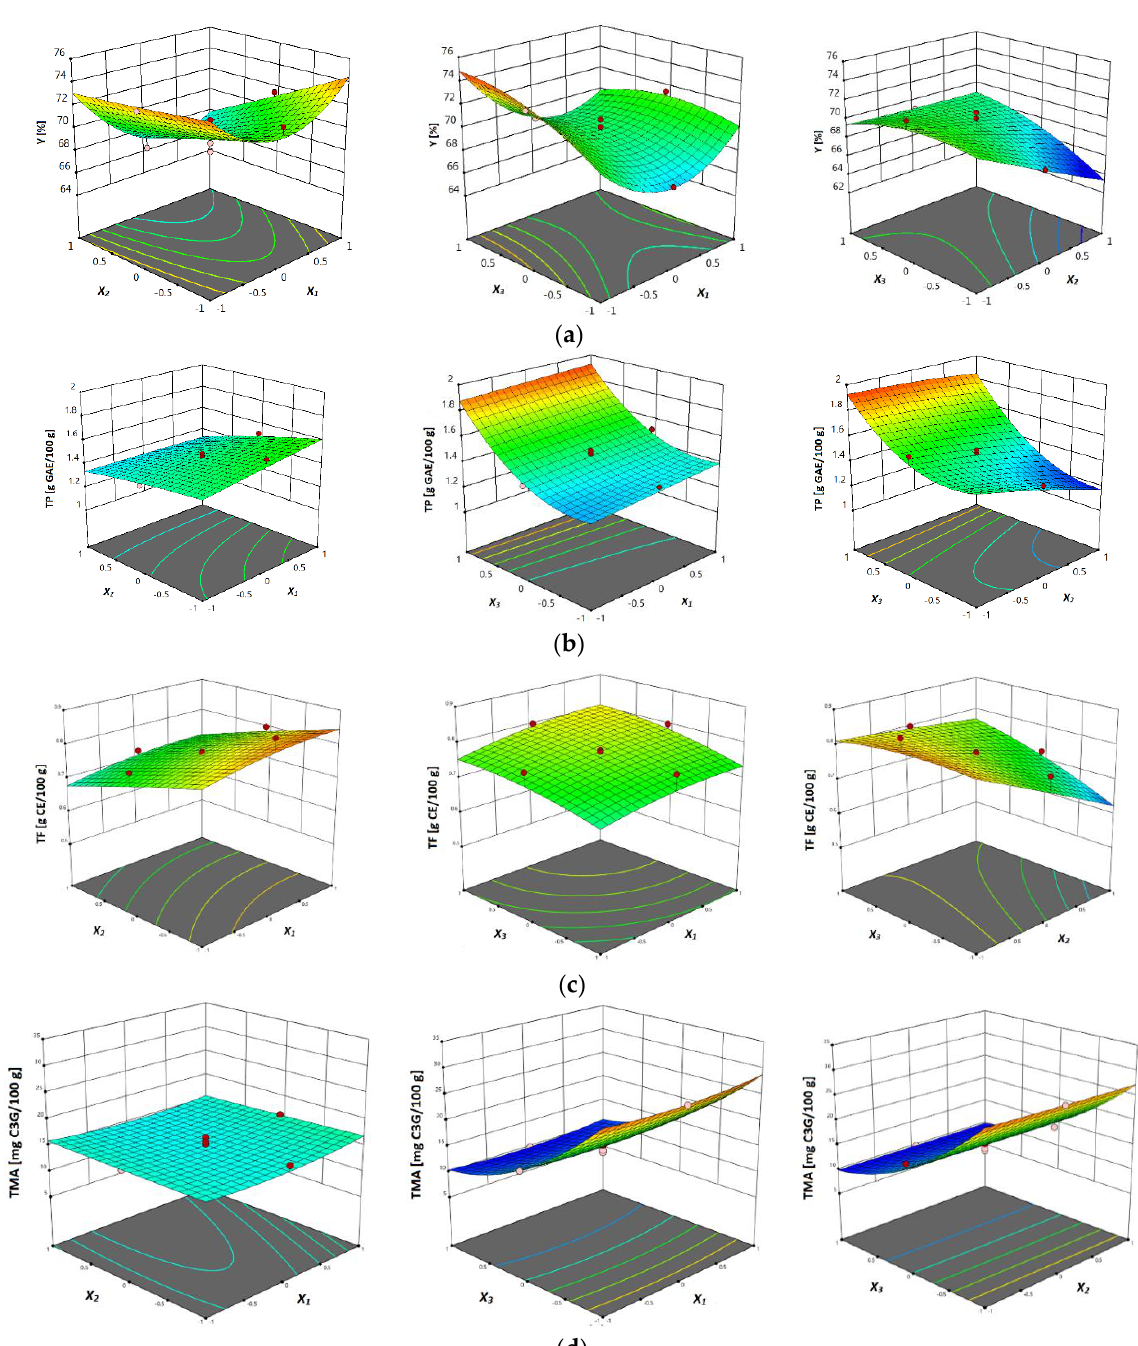
Figure 2. Response surface plots showing combined effects of UAE parameters ( x 1 —temperature; x 2 —ethanol concentration; x 3 —liquid–solid ratio) on: ( a ) yield, ( b ) total phenols content (TP), ( c ) total flavonoids content (TF) and ( d ) total monomeric anthocyanins.